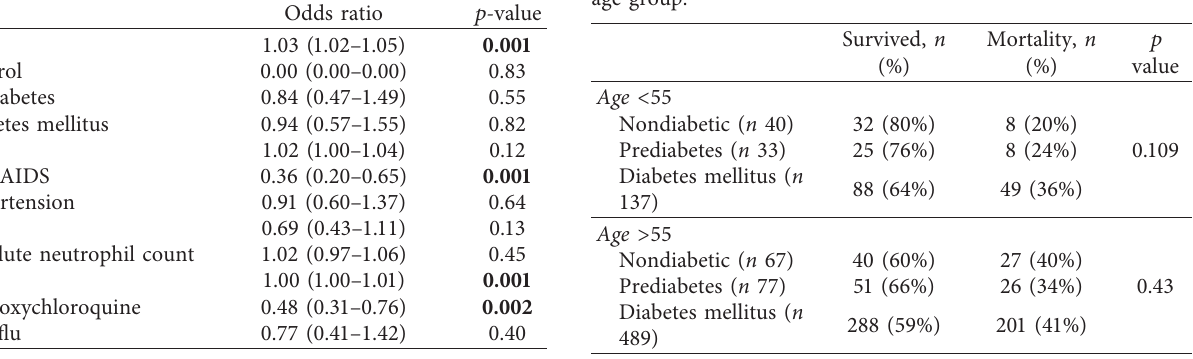
Table 2: Binomial regression analysis for mortality.